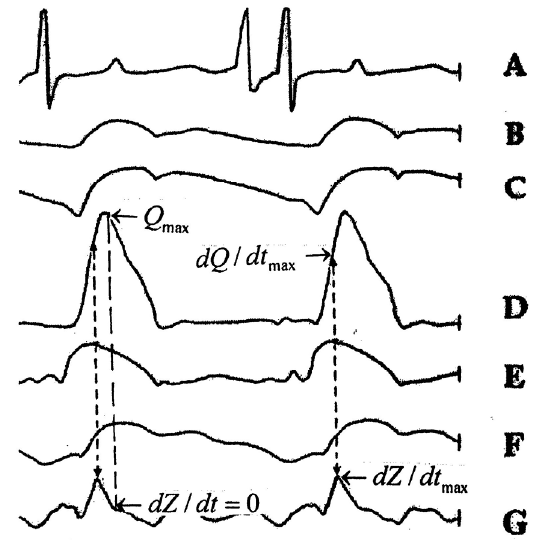
Fig. 6. Relationship between esophageal ECG (A), aortic pressure (B), aortic expansion (C), aortic blood flow (D), pulmonic expansion (E), ∆Z(t) (F), and dZ/dt (G). Note that dZ/dt max precedes peak aortic blood flow (Q max ) during the period of peak flow acceleration in early systole. Modified from reference 13.